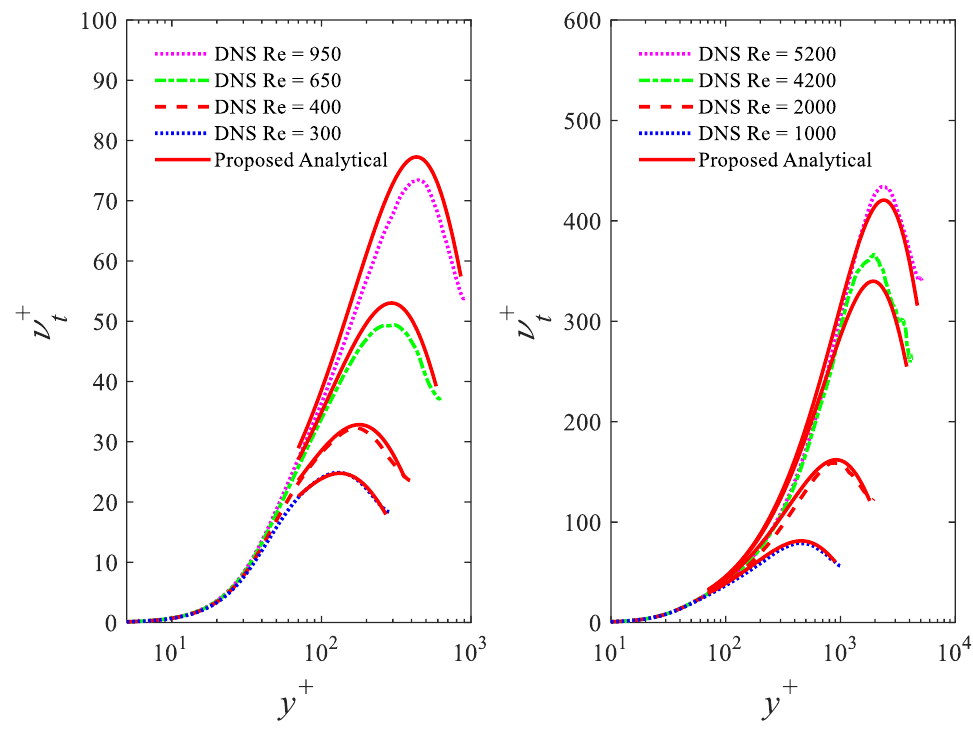
Figure 3. Eddy viscosity profiles in turbulent channel flows for different friction Reynolds numbers 𝜈 𝑡+ = 𝜈 𝑡 /𝜈 ; red solid lines: Equation (1); dotted and dashed lines: DNS data [60]. With an additional correction to account for the damping effect of turbulence near the free surface, we used [61] a damping function in order to decrease turbulent viscosity near the free surface as